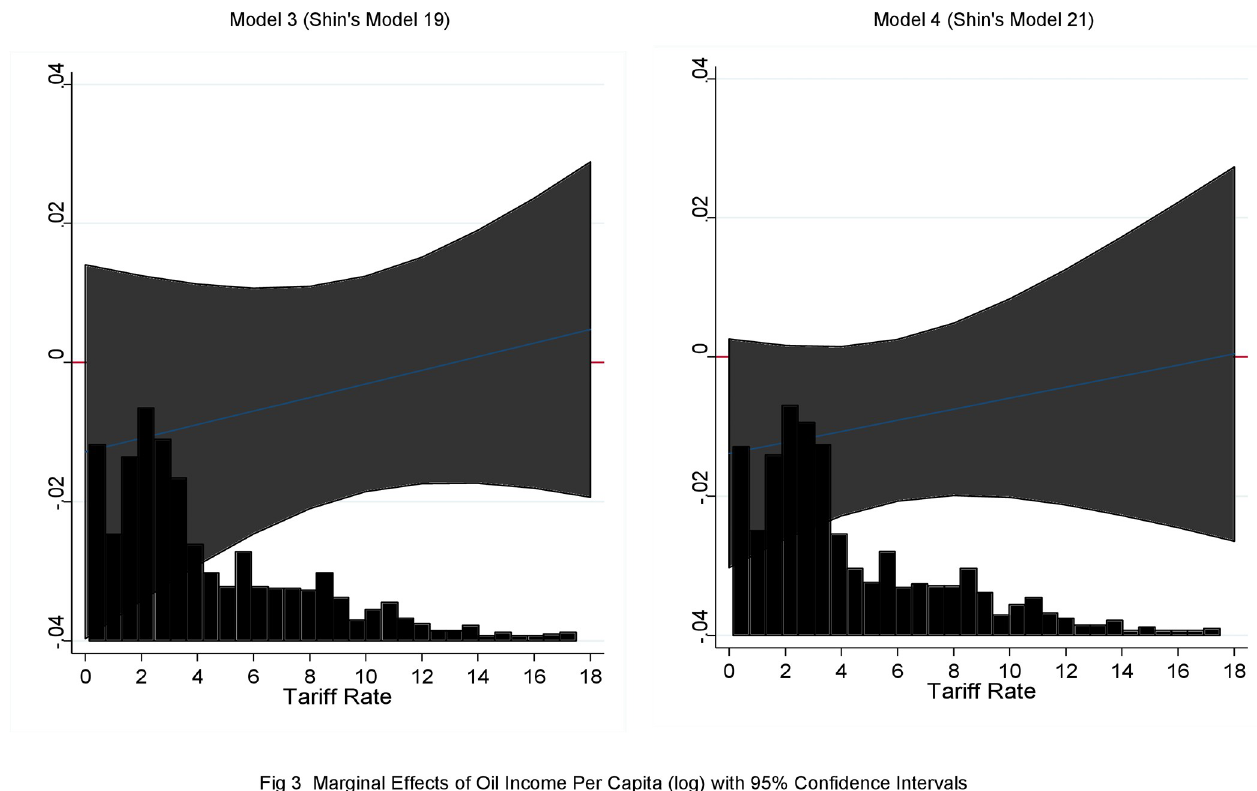
Fig 3. Marginal effects of oil income per capita (log) with 95% confidence